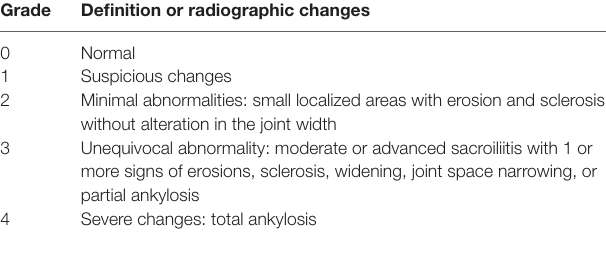
TAble 2 | Grading of radiographic sacroiliitis